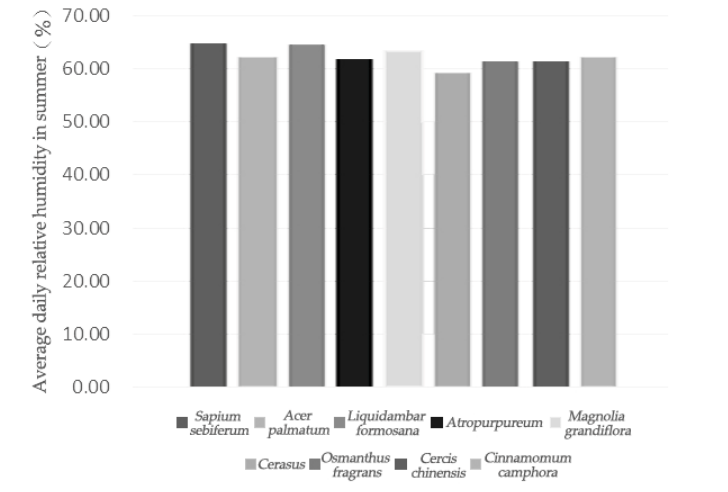
Figure 7. Average daily humidity per unit green area of different pure forests in summer.